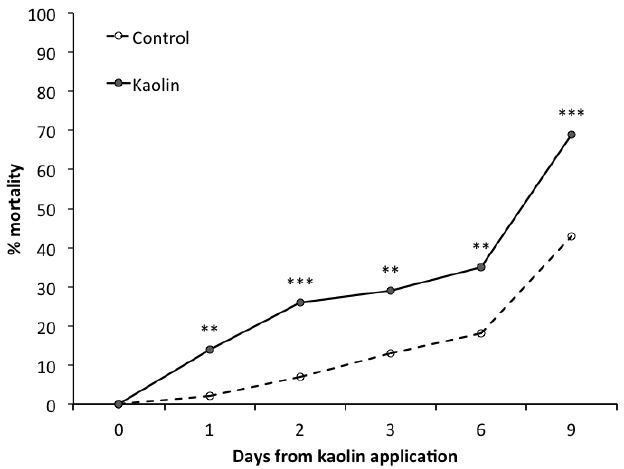
Figure 4. Scaphoideus titanus nymph mortality recorded in the laboratory in the kaolin and control. ’**’ and ‘***’ indicate significant differences for α = 0.01 and α = 0.001, respectively, according to Fisher’s exact test.